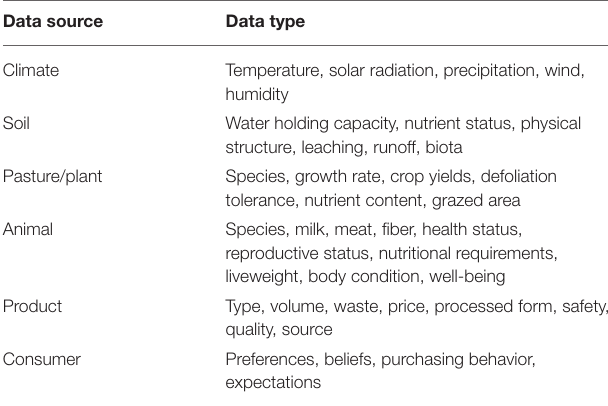
TABLE 2 | An example of the sources and types of data that will be available to collate and integrate to inform current state, predict future states, and direct